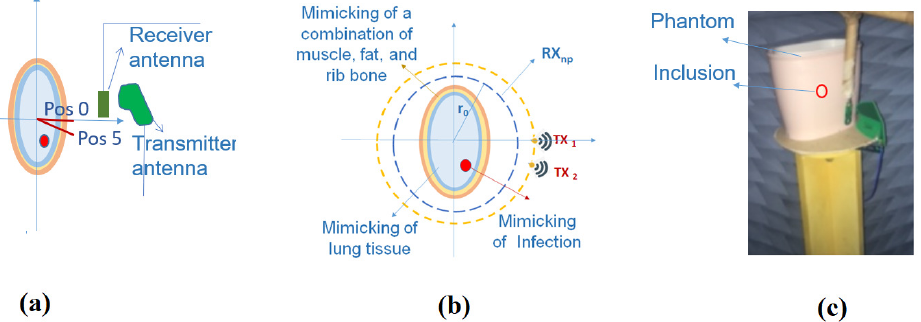
Figure 2. ( a ) The measurement set-up diagram; ( b ) pictorial top-view of the multilayered torso phantom; ( c ) phantom’s position on the center of the rotatable table inside the anechoic chamber. The external and the internal antennas are the transmitter and receiver,